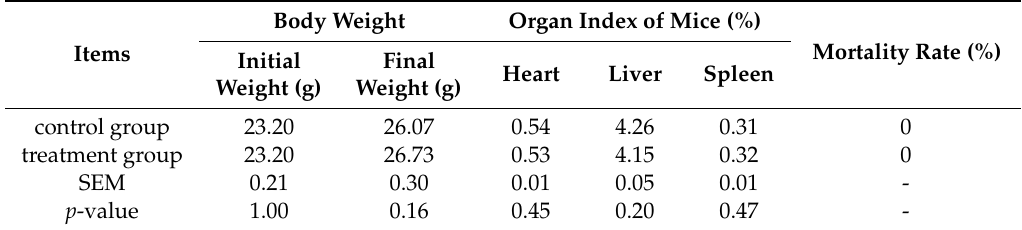
Table 5. E ff ect of administration of B. amyloliquefaciens on bodyweight and organ indices of mice.